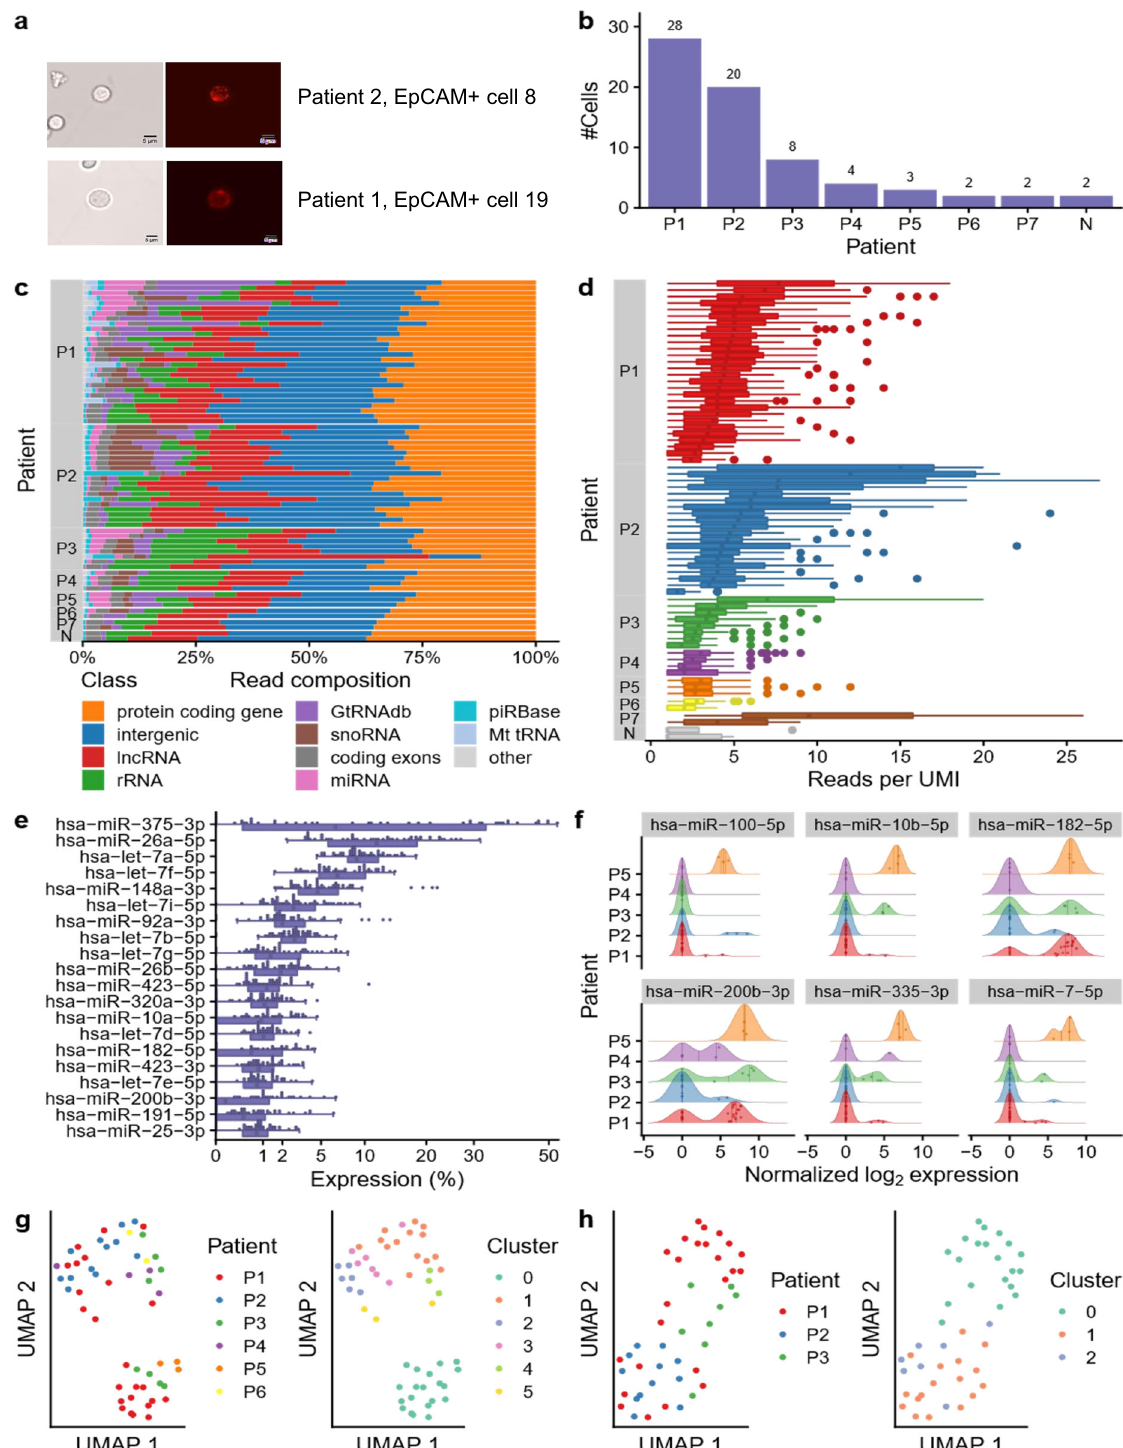
organs from the human miRNA tissue atlas 24 , miEAA proposed enrichment in the lung (GSEA, adjusted p value = 1.5 × 10 − 11 ) and the colon (GSEA, adjusted p value = 2.5 × 10 − 11 ; Fig. 5a, b). Interestingly, the results also suggest an enrichment of several cancer related pathways, such as the integrin signaling pathway (Supplementary Data 8) and cancer as disease including the miR- Walk categories 25 neoplasms (GSEA, adjusted p value = 4.6 × 10 − 8 )